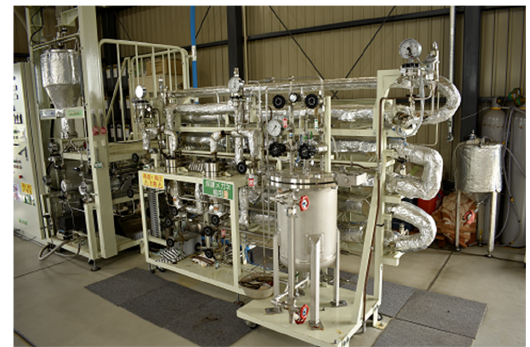
Figure 9. HTL equipment at Minamisoma (10.2 kW, 21.6 kg/day).